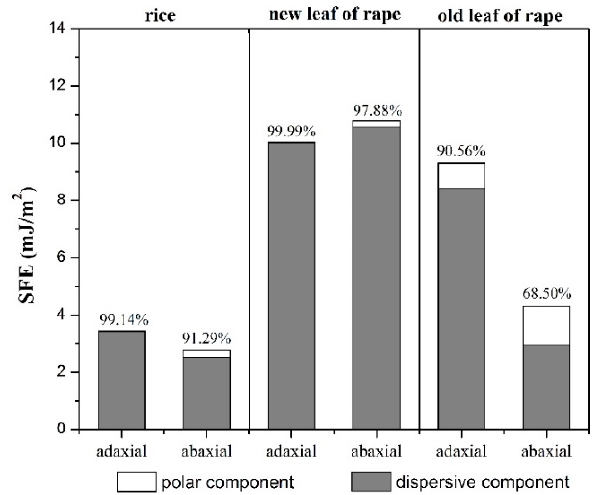
Figure 3. Surface free energy and its components of rice leaf and rape leaf on both adaxial and abaxial surfaces (% represents the ratio of dispersive component to the SFE).